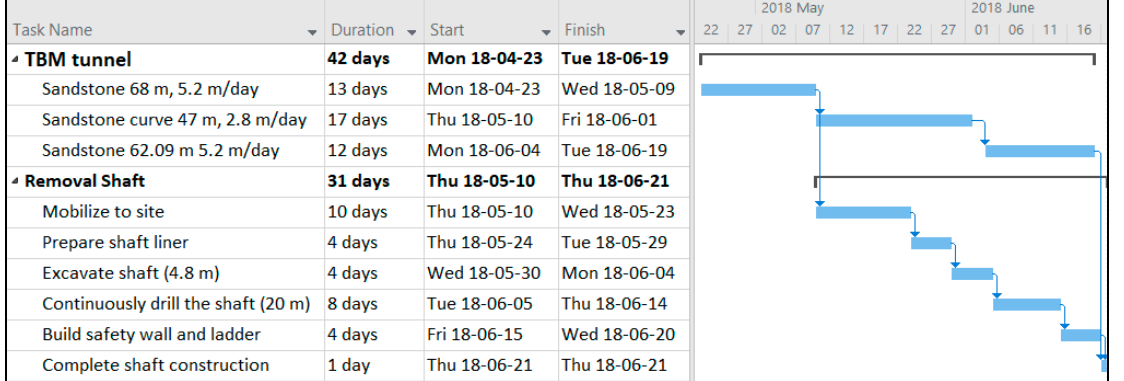
Figure 5. The contractor’s planned schedule of the tunneling segment.